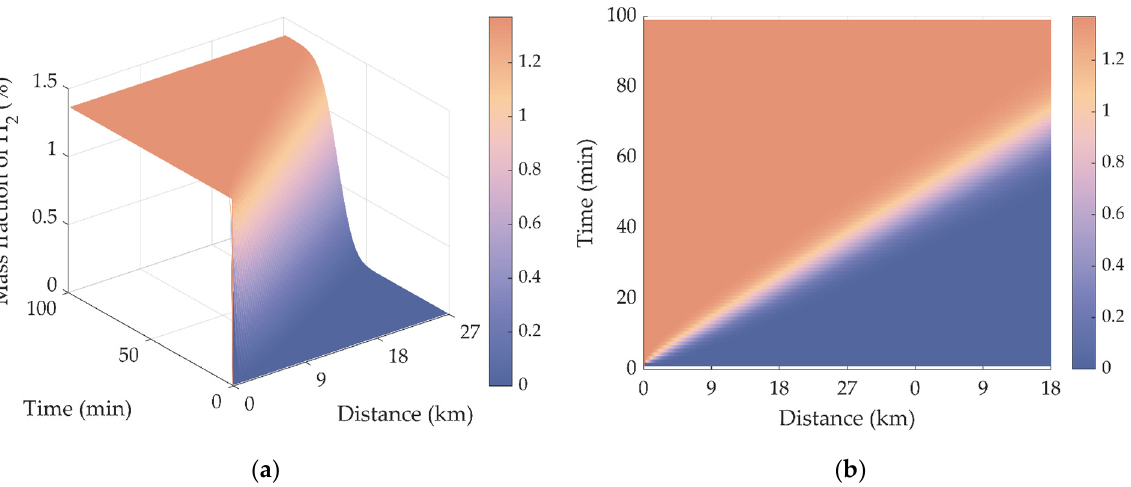
Figure 6. The distribution of hydrogen mass fraction in Pipe 1: ( a ) Three-dimensional diagram; ( b ) top view.